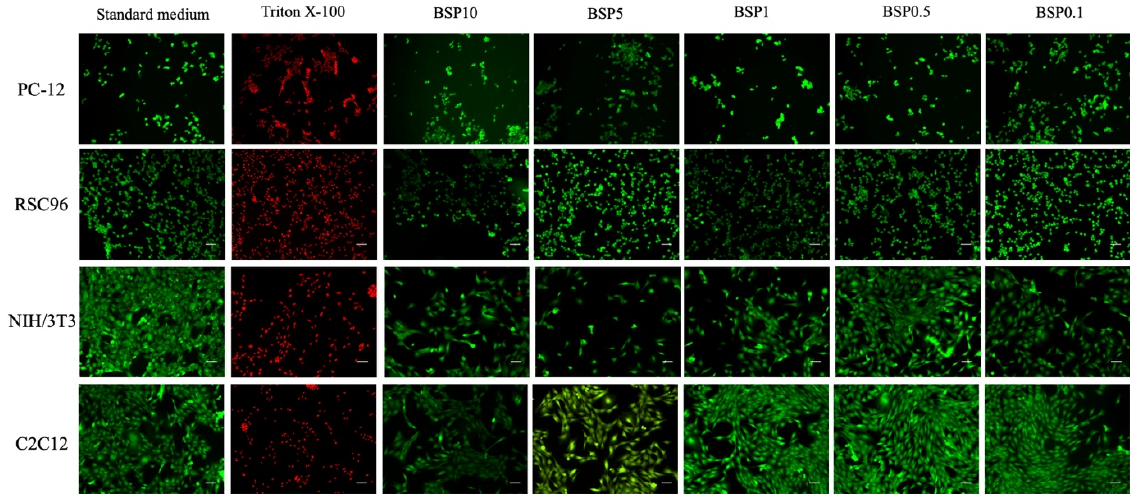
Figure 6. ( a , c ) Higher cytotoxicity was observed in PC-12 and NIH/3T3 cell lines after culture in high-concentration of CMC/BSP (10, 5, and 1 mg/mL)/RES sponge (cytotoxicity > 20%) using the LDH assay kit. ( b , d ) There were no significant differences between RSC96 and C2C12 cell lines after culture in CMC-BSP-RES sponges at different concentrations. ***: p < 0.001.